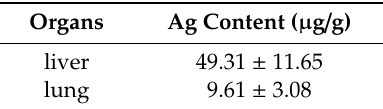
Table 1. The content of silver in the organs of mice after receiving multi-dose administration of gold nanorods core / silver shell nanostructures (Au@Ag NRs) analyzed by inductively coupled plasma mass spectrometer (ICP-MS).